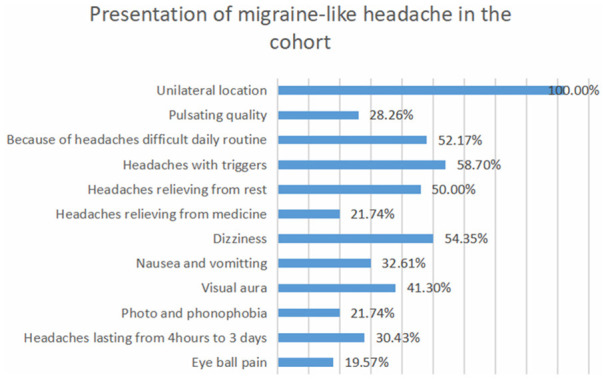
Presentation of migraine-like headache in the cohort.